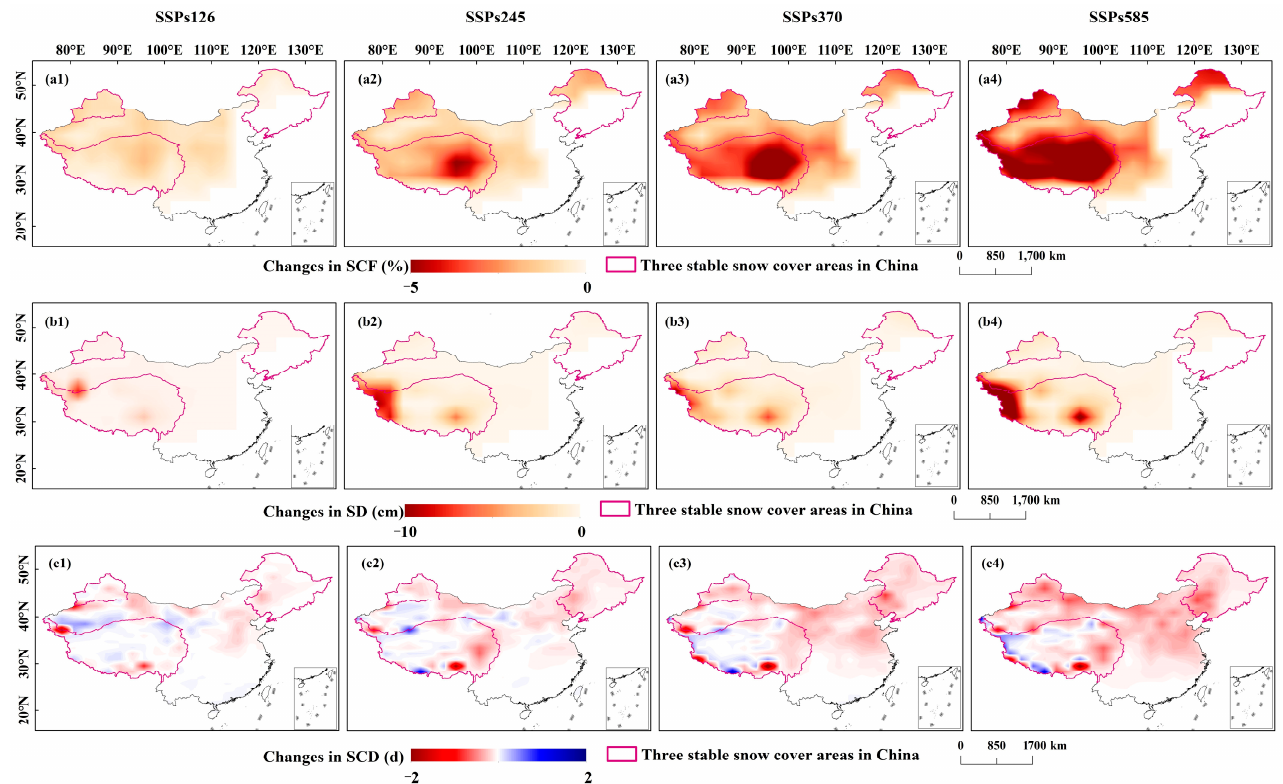
Figure 9. Spatial distribution of average SCF ( a ), SD ( b ), and SCDs ( c ) in the TP, NX, and NC under SSPs126 ( a1 – c1 ), SSPs245 ( a2 – c2 ), SSPs370 ( a3 – c3 ), and SSPs585 ( a4 – c4 ) between 2015–2050